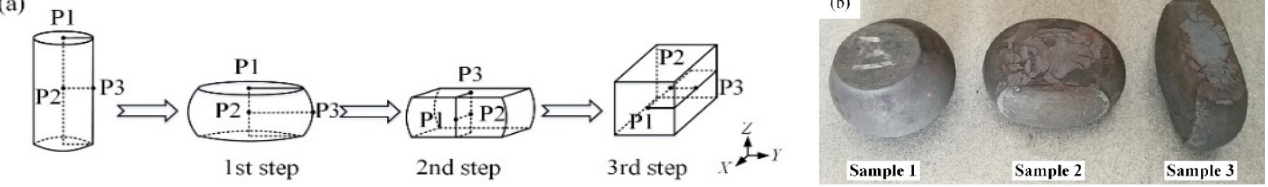
Figure 1. MDF experiment: ( a ) sequence of MDF steps; ( b ) state of SDP1 steel after MDF.